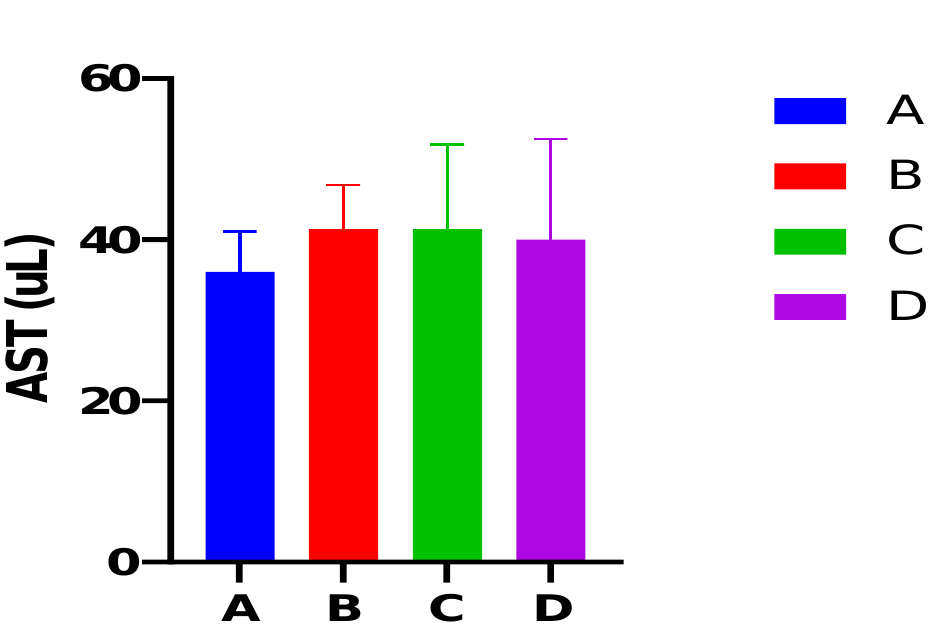
Fig.1: Graph showing the mean value of Aspartate Aminotransferase (AST) across the groups